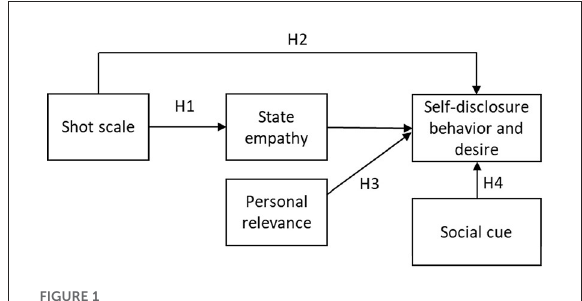
FIGURE1 Overview of hypotheses in Study 1.